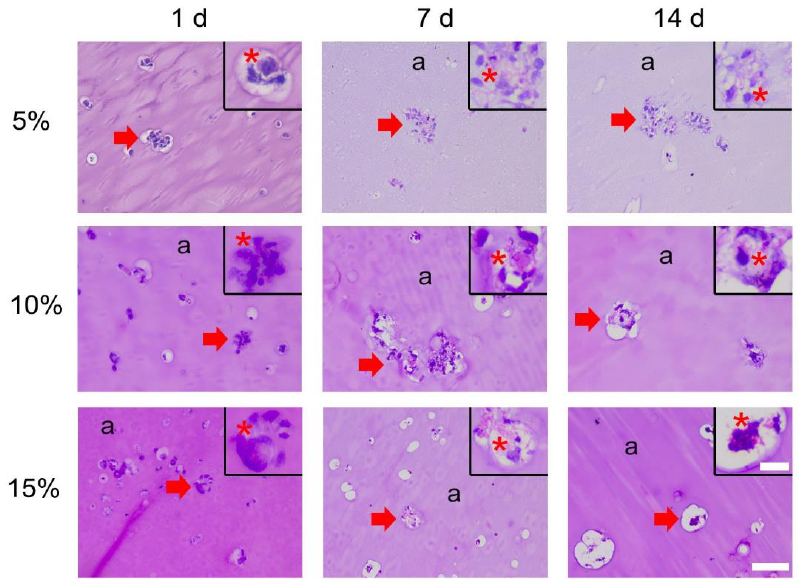
Figure 2. H&E stain of 5%, 10%, and 15% GelMA loaded with ASCs. Overview (Scale bar 100 µm) indicates the hydrogel (a) and the areas of clustered cells (red arrow). Such clustered areas are shown in the magnified view (Scale bar 25 µm), positive Hematoxylin (i.e., nuclei) seen as intense purple indicated with a red asterisk.